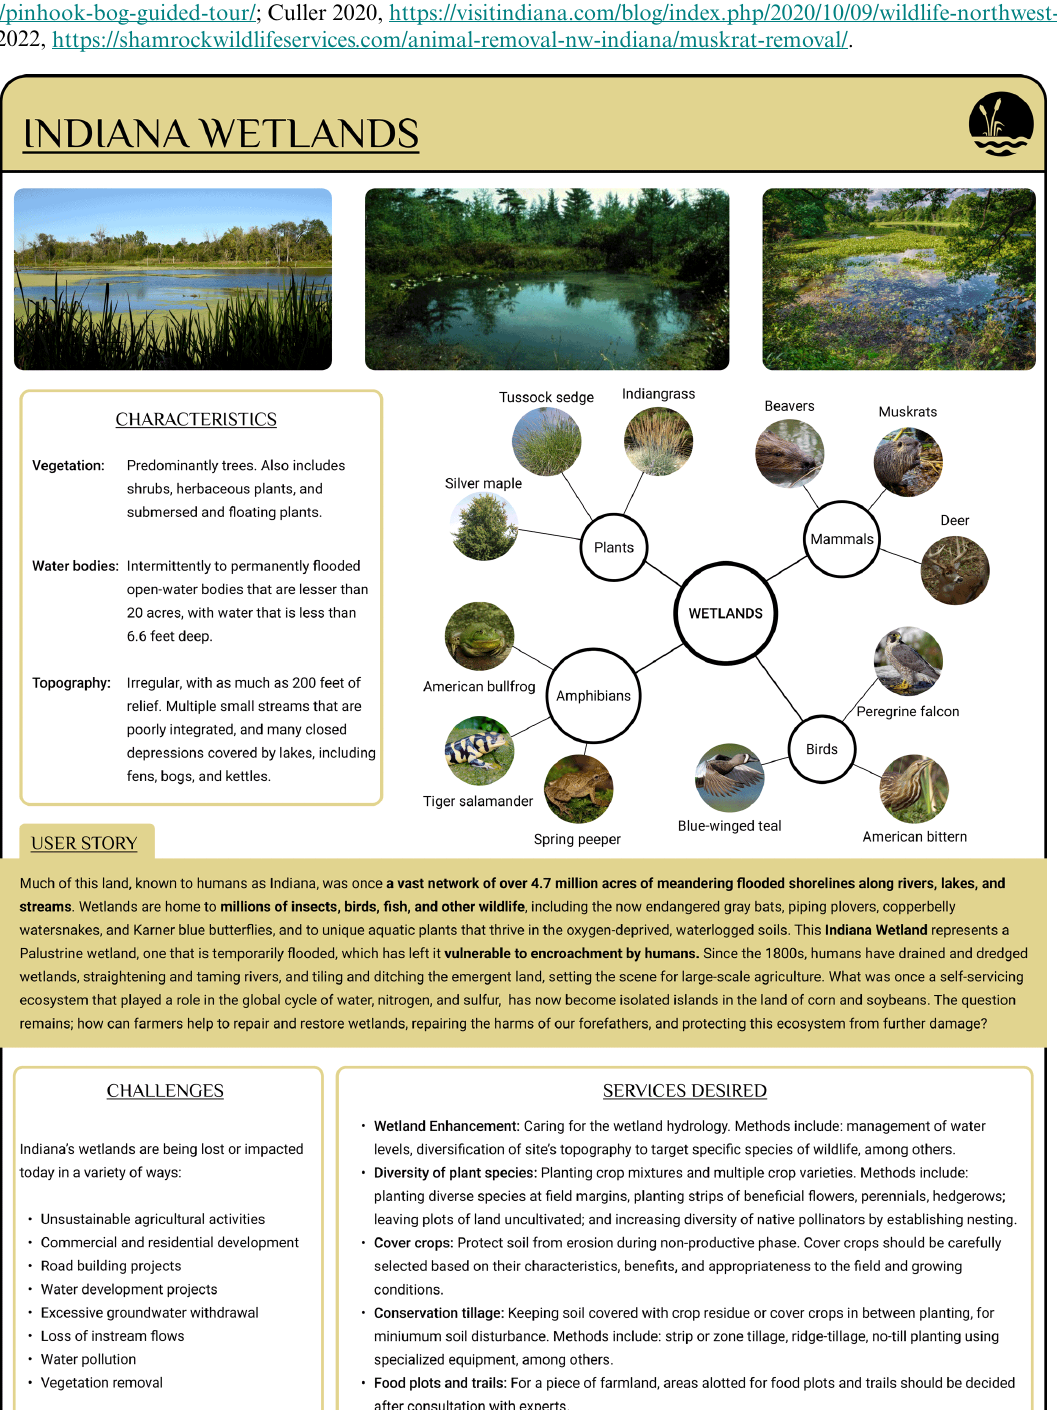
Fig. 1 . A prototypical example of the ecosystema tool representing an Indiana wetland. Material in this ecosystema, including images, were drawn from U.S. Geological Survey 1996, Indiana Department of Natural Resources 2002, Wszelaki and